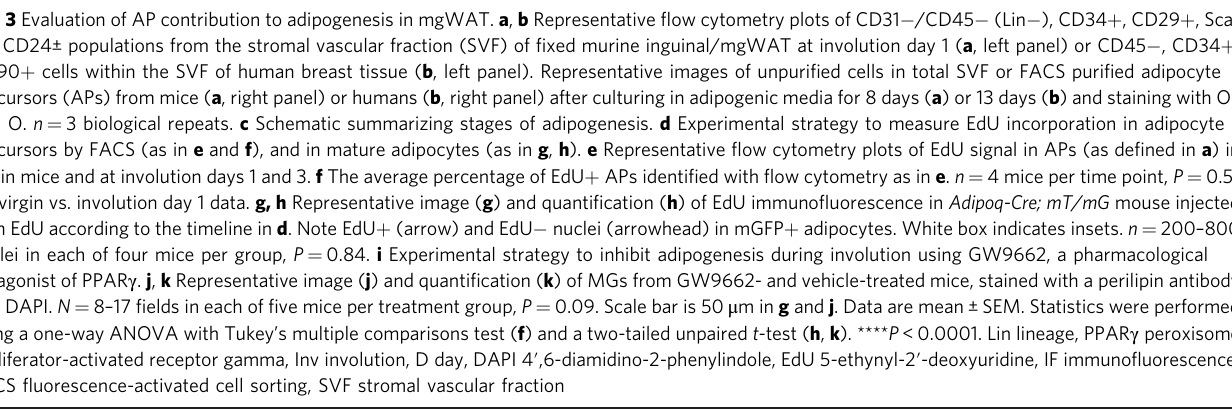
Fig. 3 Evaluation of AP contribution to adipogenesis in mgWAT. a , b Representative fl ow cytometry plots of CD31 − /CD45 − (Lin − ), CD34 + , CD29 + , Sca- 1 + , CD24± populations from the stromal vascular fraction (SVF) of fi xed murine inguinal/mgWAT at involution day 1 ( a , left panel) or CD45 − , CD34 + , CD90 + cells within the SVF of human breast tissue ( b , left panel). Representative images of unpuri fi ed cells in total SVF or FACS puri fi ed adipocyte precursors (APs) from mice ( a , right panel) or humans ( b , right panel) after culturing in adipogenic media for 8 days ( a ) or 13 days ( b ) and staining with Oil Red O. n = 3 biological repeats. c Schematic summarizing stages of adipogenesis. d Experimental strategy to measure EdU incorporation in